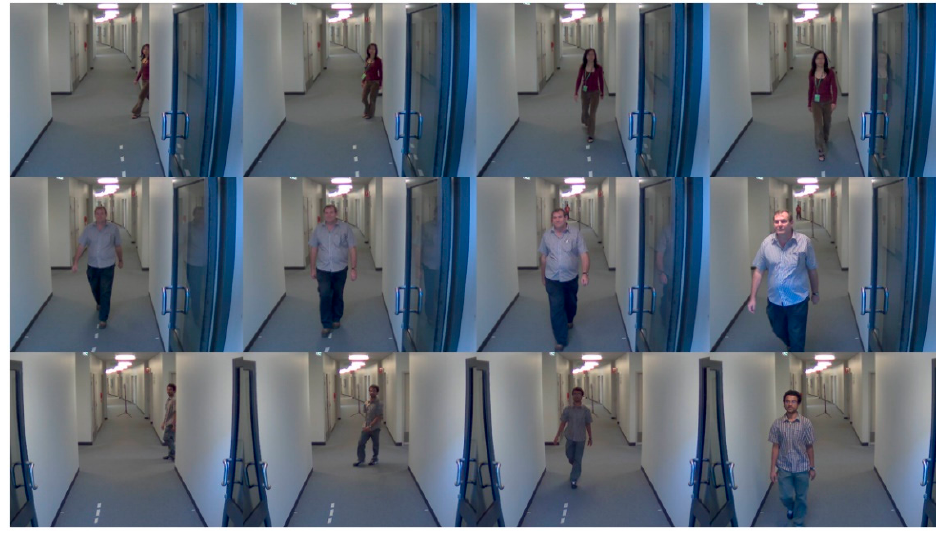
Figure 4. Example images for ChokePoint dataset.